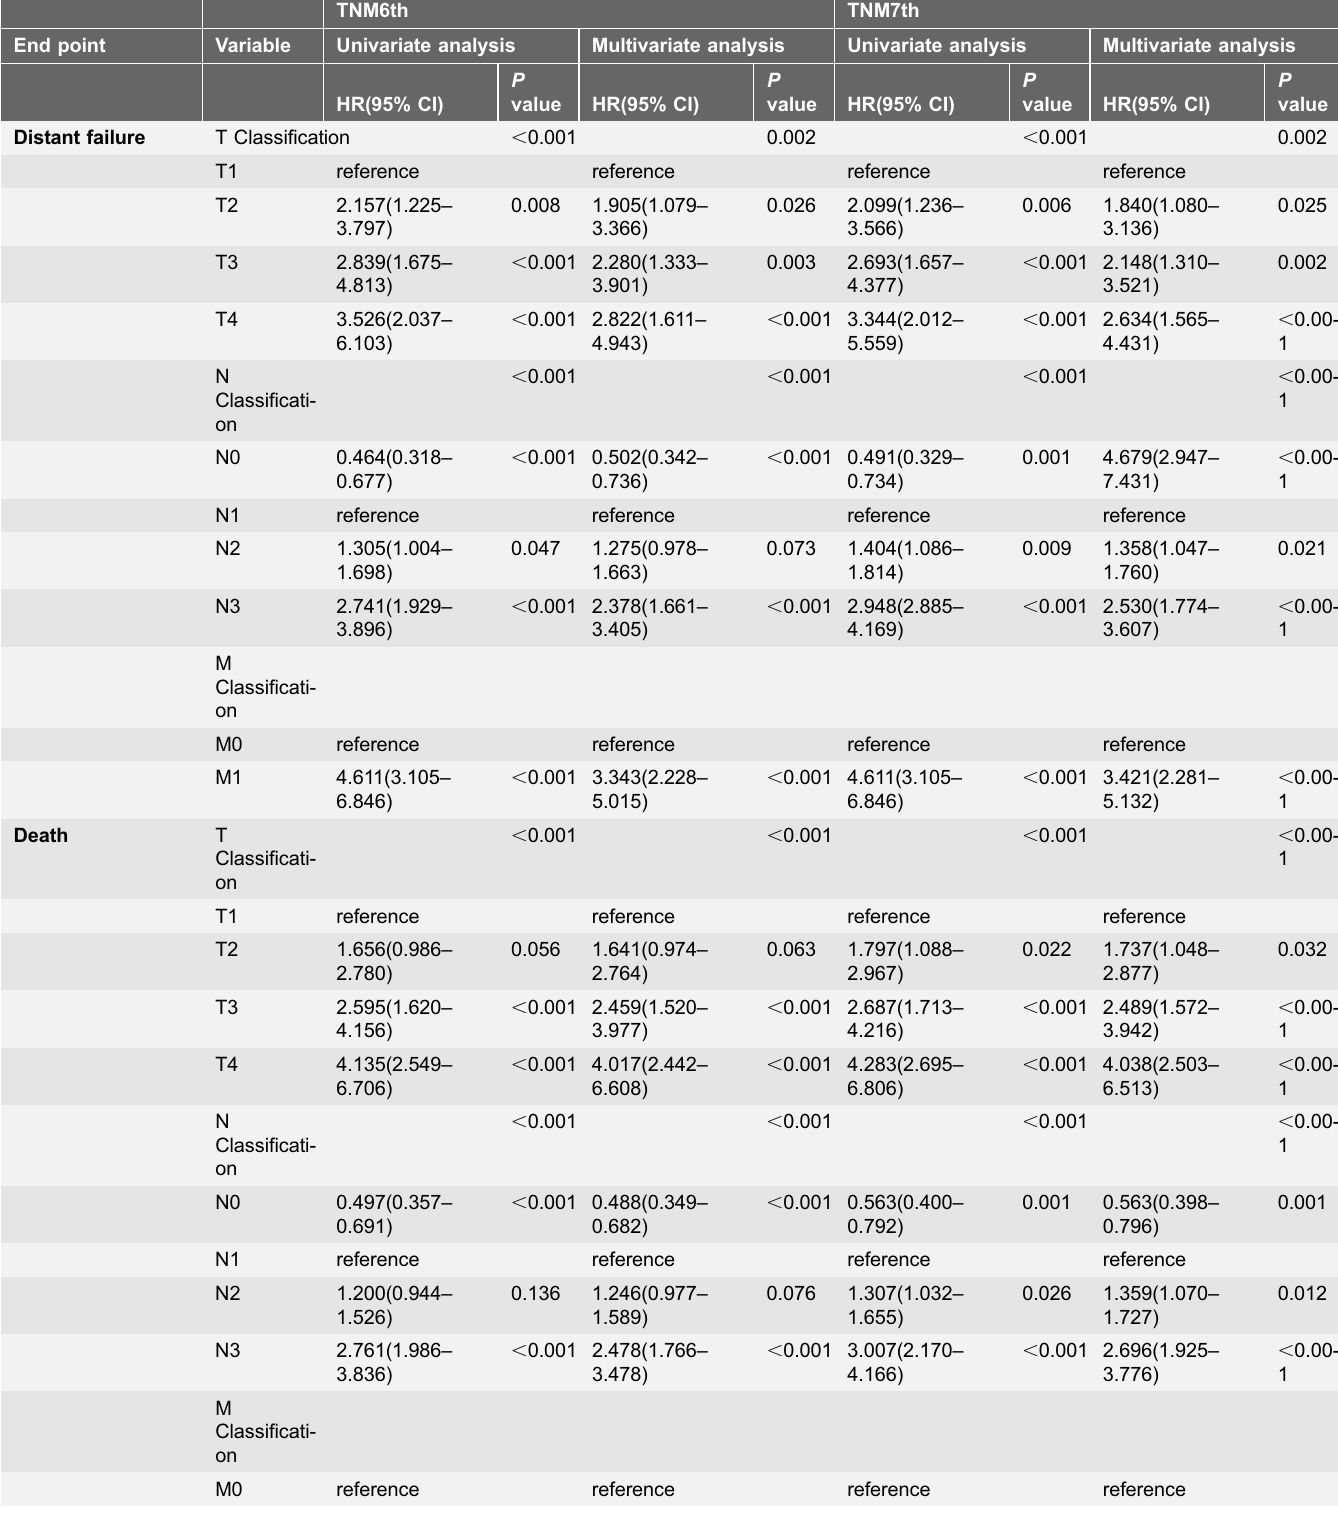
Table 3. Multivariate analysis of independent prognostic factors in NPC